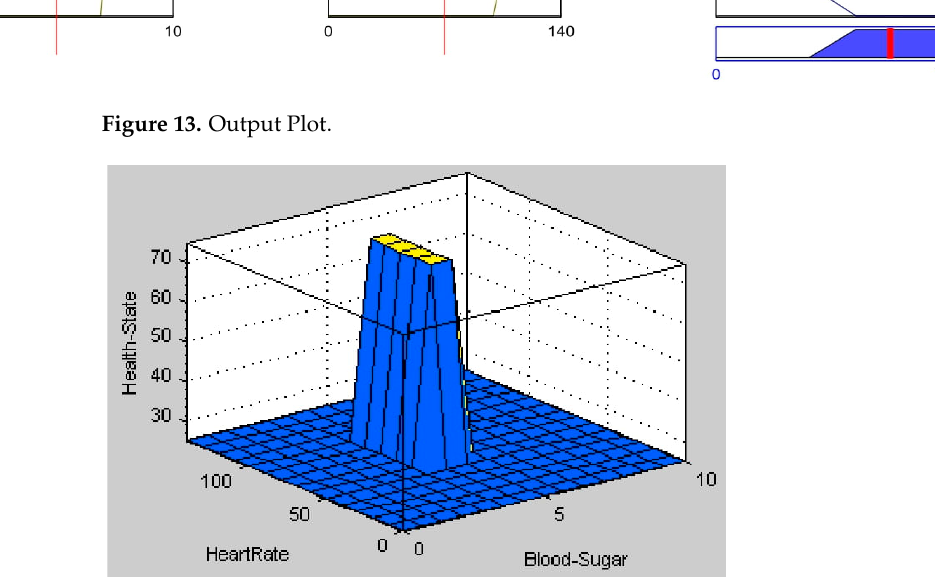
Figure 14. Surface Viewer for Health State diagnosis.